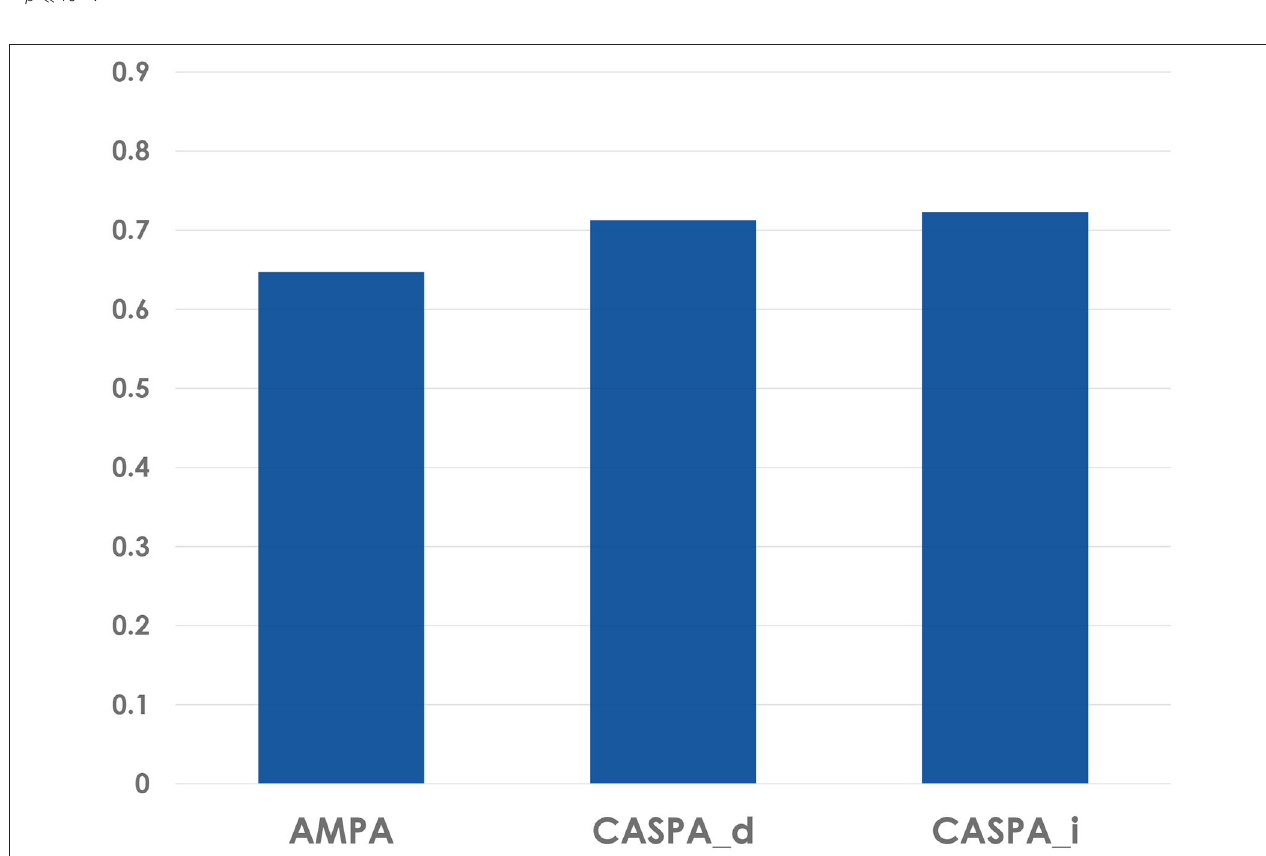
FIGURE 5 | Balanced accuracies of different SDA-M-based algorithms for error prediction in the Kanku-dai sequence.